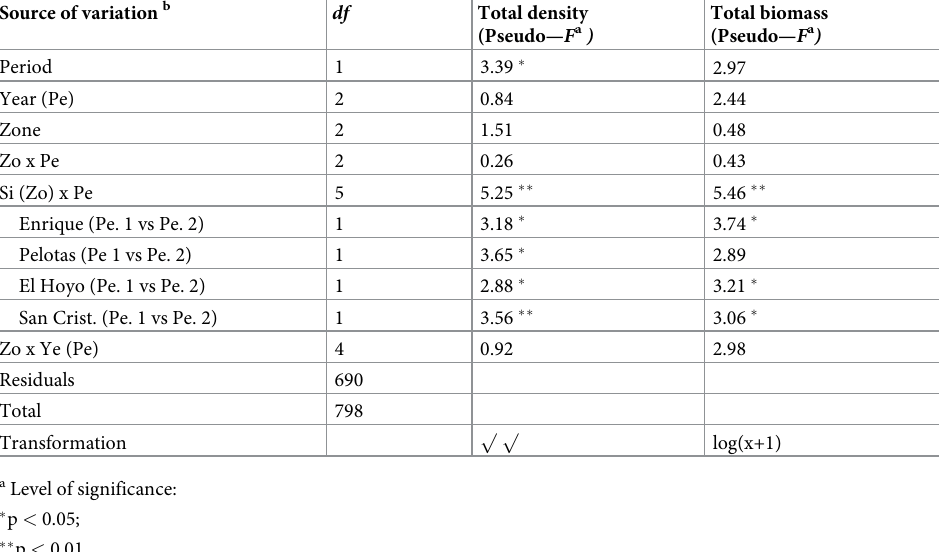
Table 8. Summary of univariate PERMANOVA results of total density (fish/m 2 ) and biomass (g/m 2 ) of commer- cial species in the LPNR.